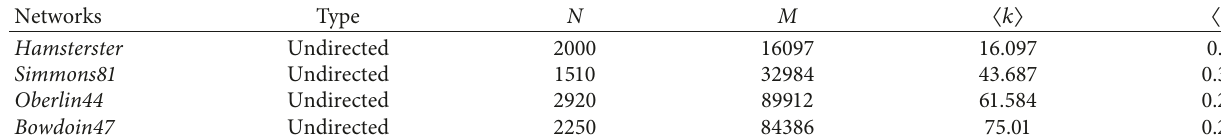
Table 3: Comparison of network parameters among four real-world network